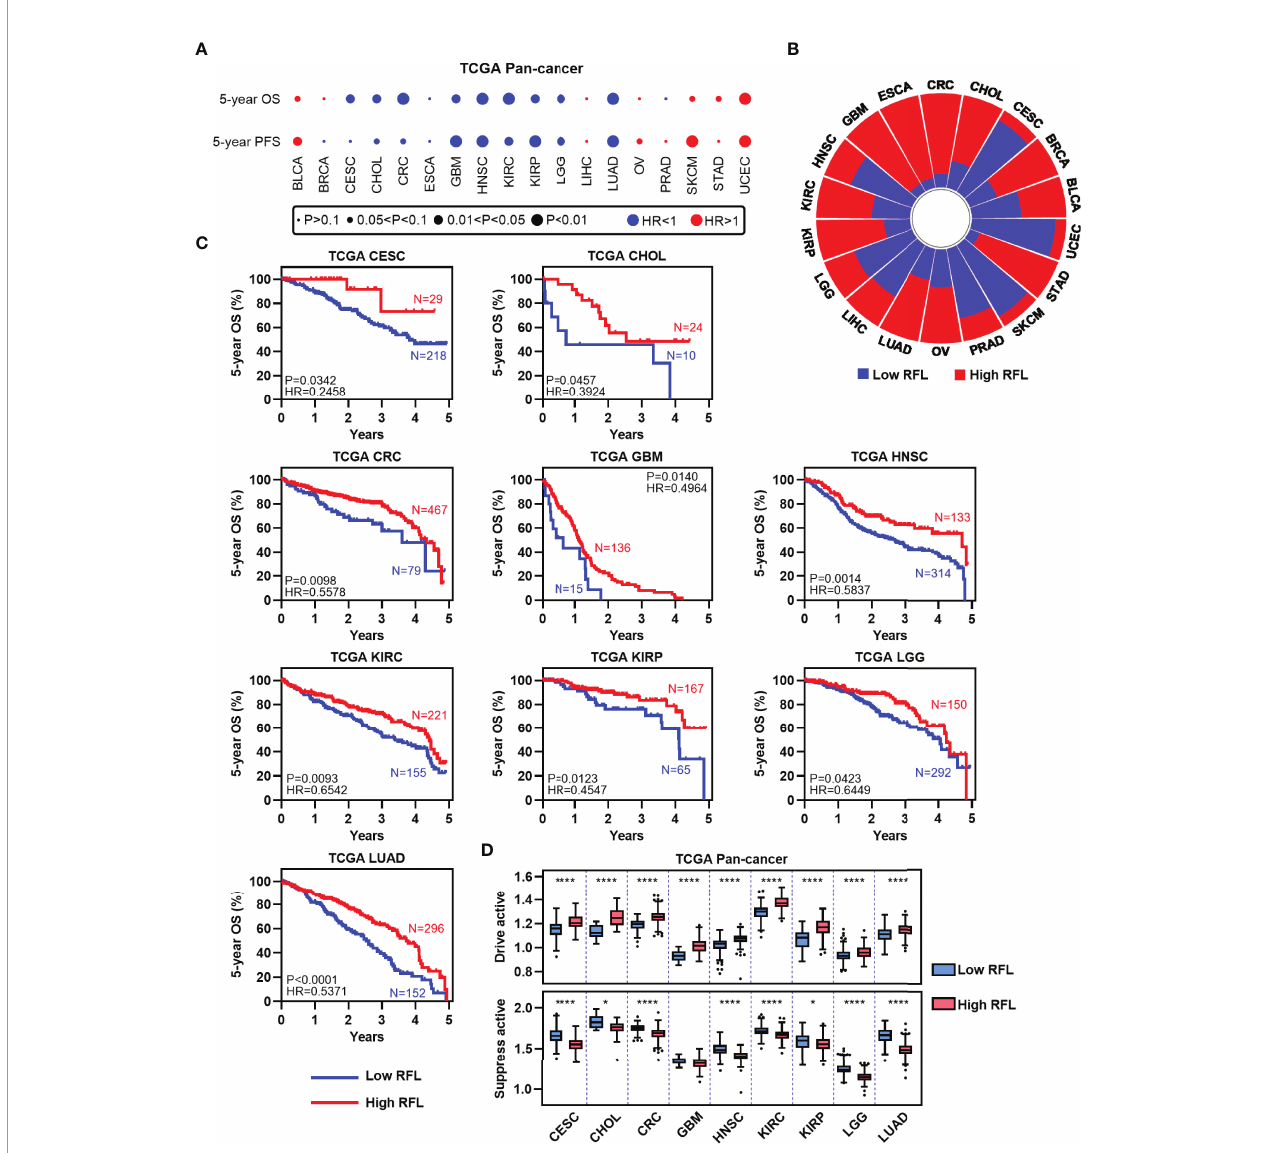
FIGURE 2 | High RFL tumors were consistently associated with worse prognosis across cancer types. (A) Association of ferroptotic status with patient OS and PFS times based in different cancer types from the TCGA. (B) Percentage of samples with high and low RFL classi fi cations across multiple cancer types from the TCGA. (C) Kaplan – Meier plots show that high RFL cases were associated with worse OS time in multiple cancer types from the TCGA. (D) Box plots showing the ferroptosis drivers/suppressors active level in TCGA multiple cancer types grouped by (C) . *P< 0.05, **P < 0.01, ***P <0.001, ****P <